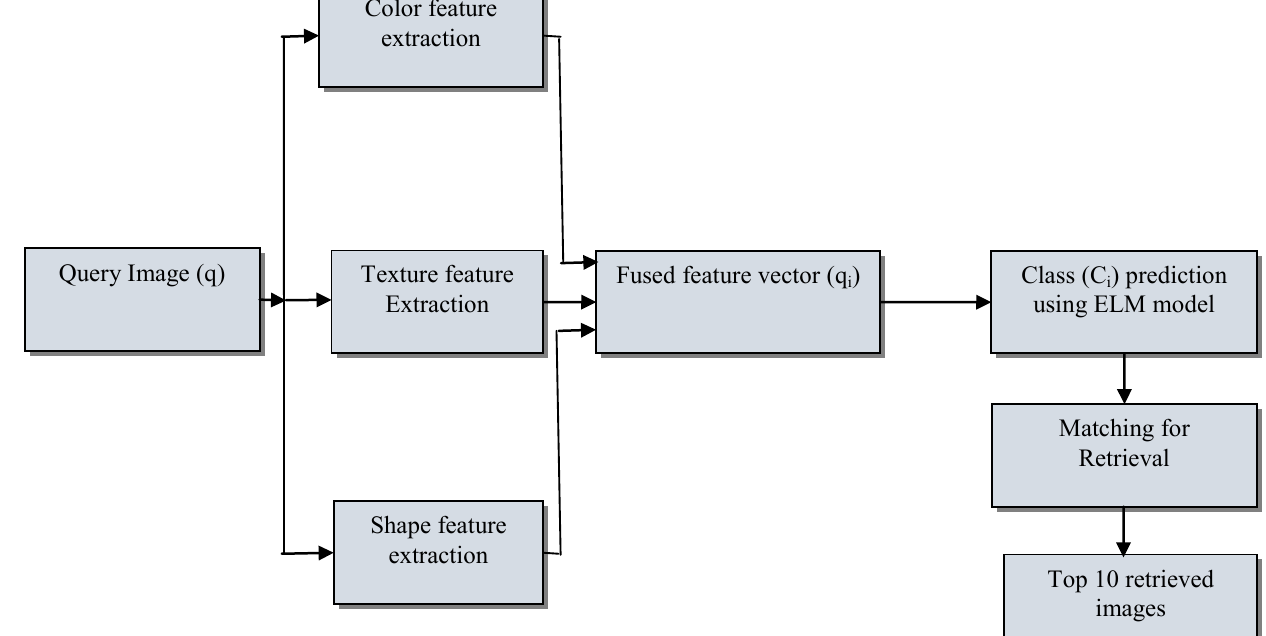
Figure 4 b . Testing phase of the proposed